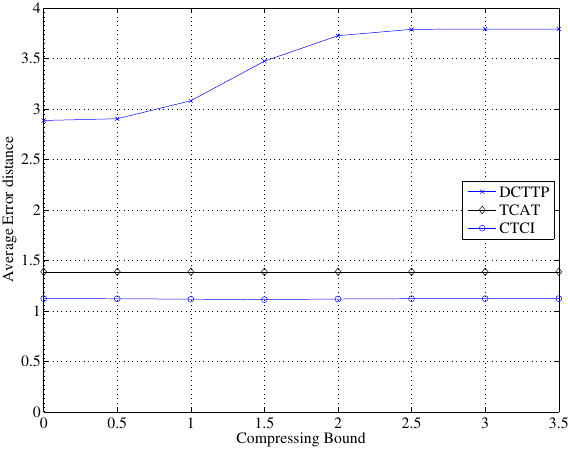
Figure 24. Impact of the compressing bound on the average error